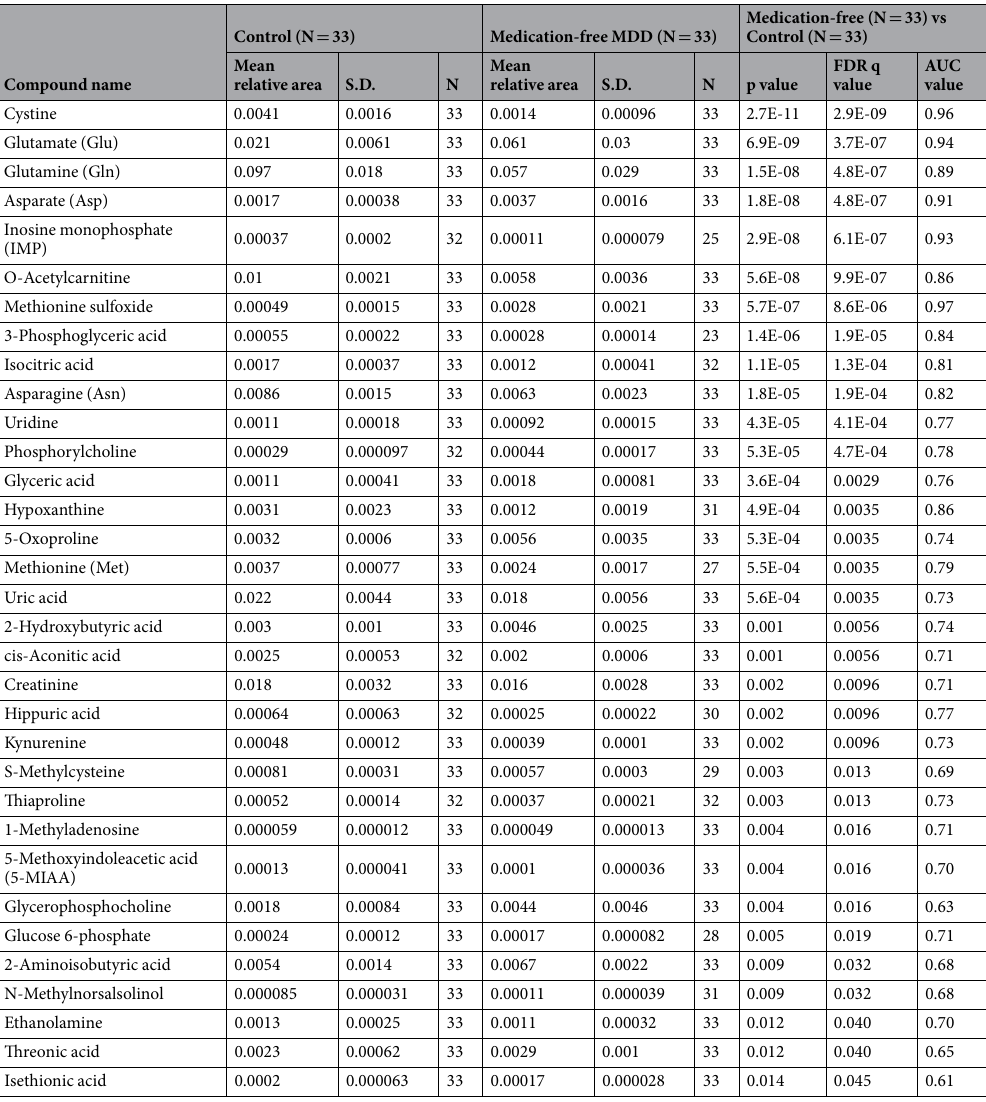
Table 2. Differences in metabolites in the medication-free MDD patients and control